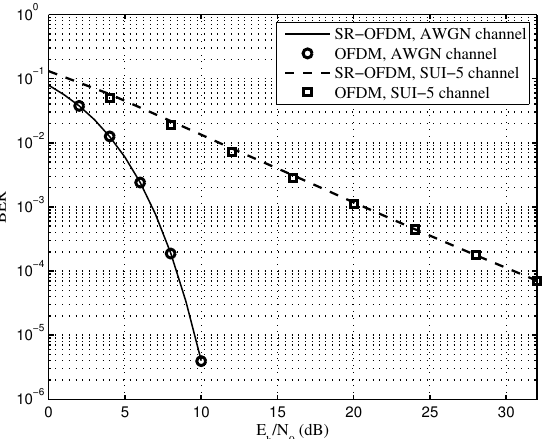
Figure 10. BER comparison between the classical OFDM and the proposed SR-OFDM, perfect channel